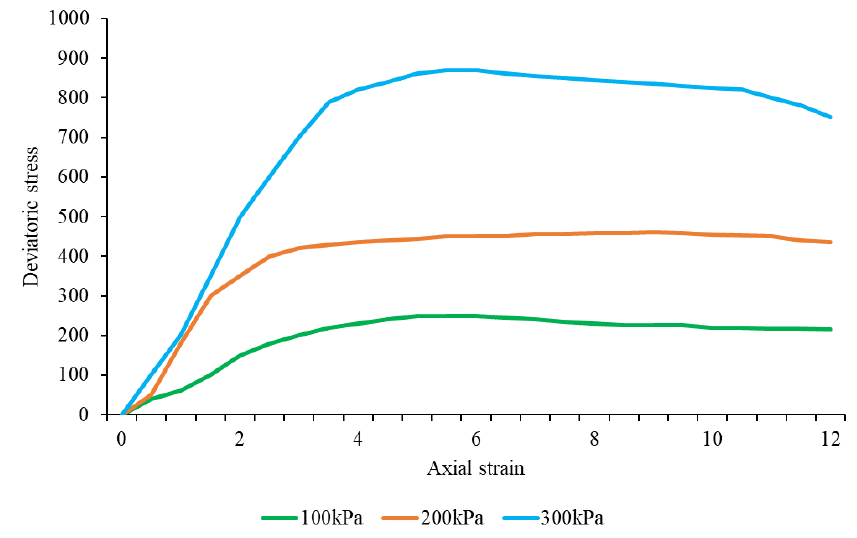
Figure 3. Deviatoric stress curves of sandy soil under different confining